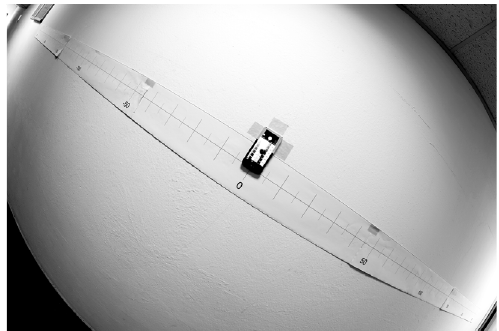
Figure 6 . Photo of the metric target obtained with a diagonal fisheye, the Samyang 12mm.